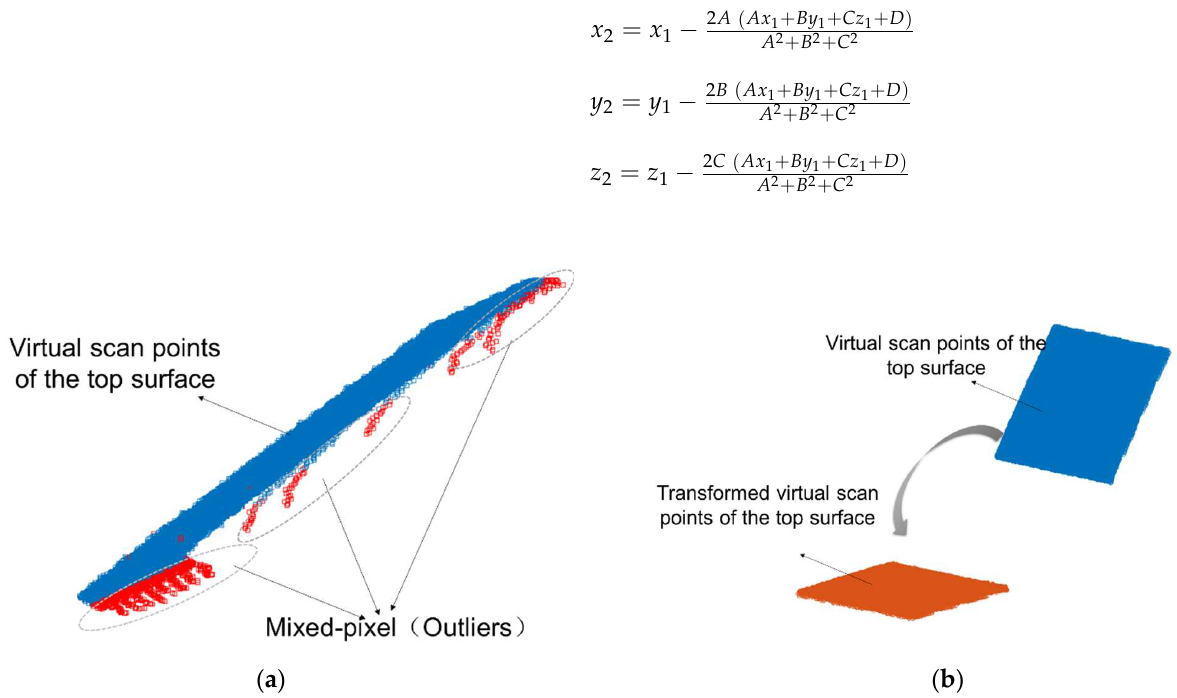
Figure 8. Transformation of the virtual scan points of the top surface on the specimen: ( a ) removal of the mixed-pixel outliers using the RANSAC algorithm and ( b ) transformation of the virtual scan points to the position of the actual scan points of the top surface of the specimen.